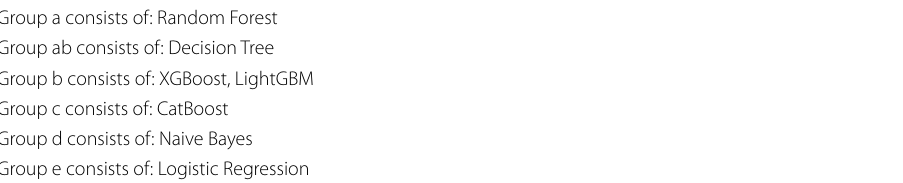
Table 11 HSD groupings of classifiers after 2-factor ANOVA where classifier and sampling ratio are factors with Brute Force web attacks; groups are by performance in terms of AUC Group a consists of: Random Forest Group ab consists of: Decision Tree Group b consists of: XGBoost, LightGBM Group c consists of: CatBoost Group d consists of: Naive Bayes Group e consists of: Logistic